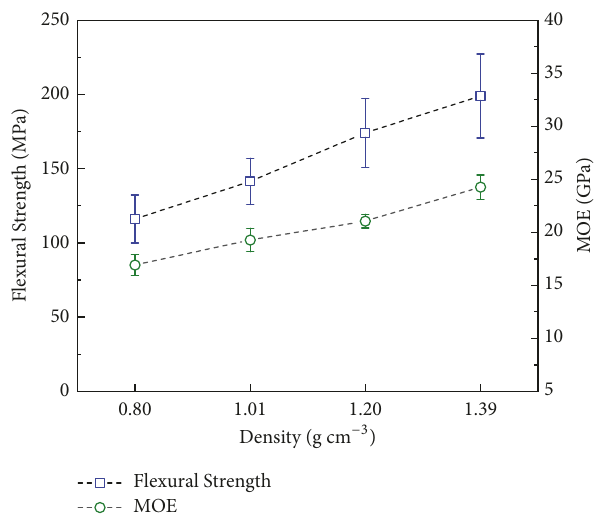
Figure 5: Flexural properties of scrimbers with various densities.